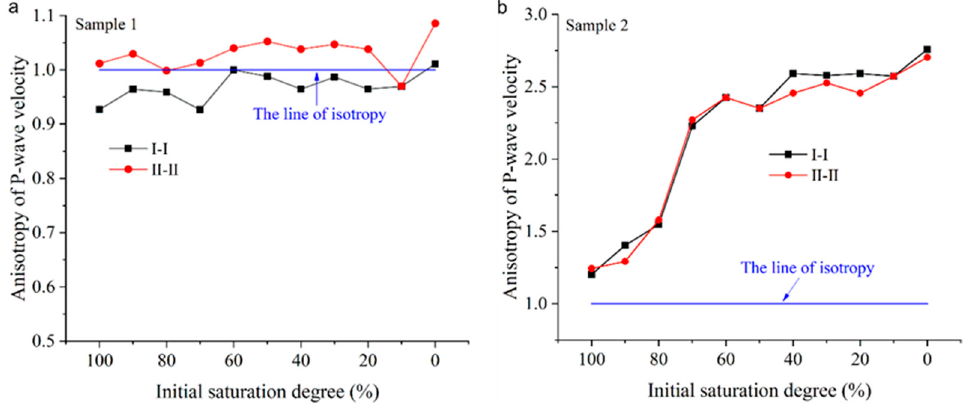
Figure 3. Variation in anisotropy with saturation in samples ( a ) 1 and ( b ) 2.